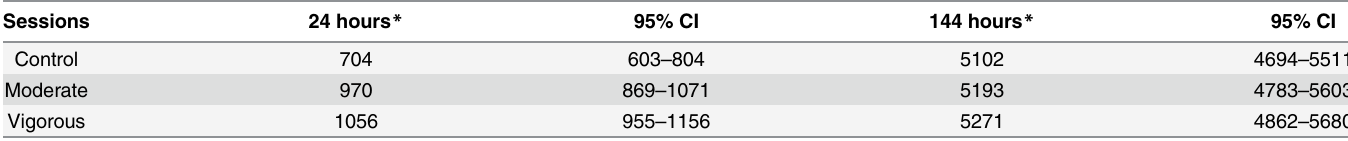
Table 3. Estimated means * and confidence intervals of energy expenditure with physical activities (kcal) within 24 hours and 144 hours of monitoring. Sessions